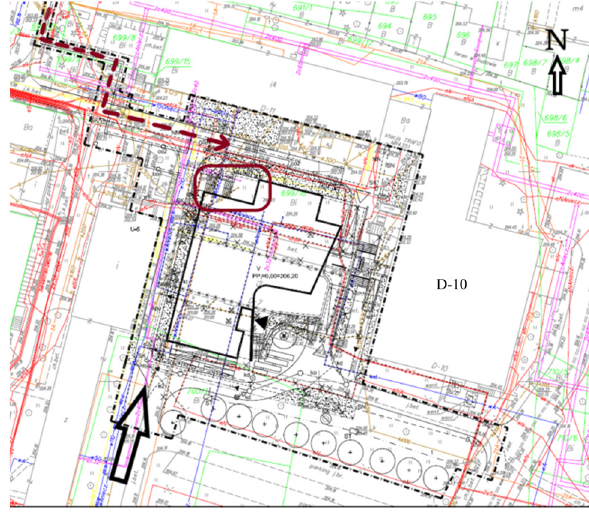
Figure 2: A schematic plan of the area development of the FPACS building with possible access. Source: AGH university procurement documentation.